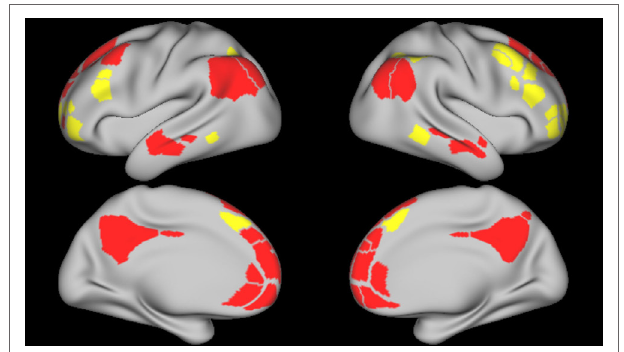
FigUre 2 | Frontoparietal and default mode network parcels. Figure depicts the frontoparietal network (yellow) and the default mode network (red) parcels, derived from boundary-map parcelation [Gordon et al. (27)]. Top images represent the left and right lateral brain surfaces, respectively. Bottom images represent the left and right medial brain surfaces. The same cortical parcels were used in both control and schizophrenia participants.